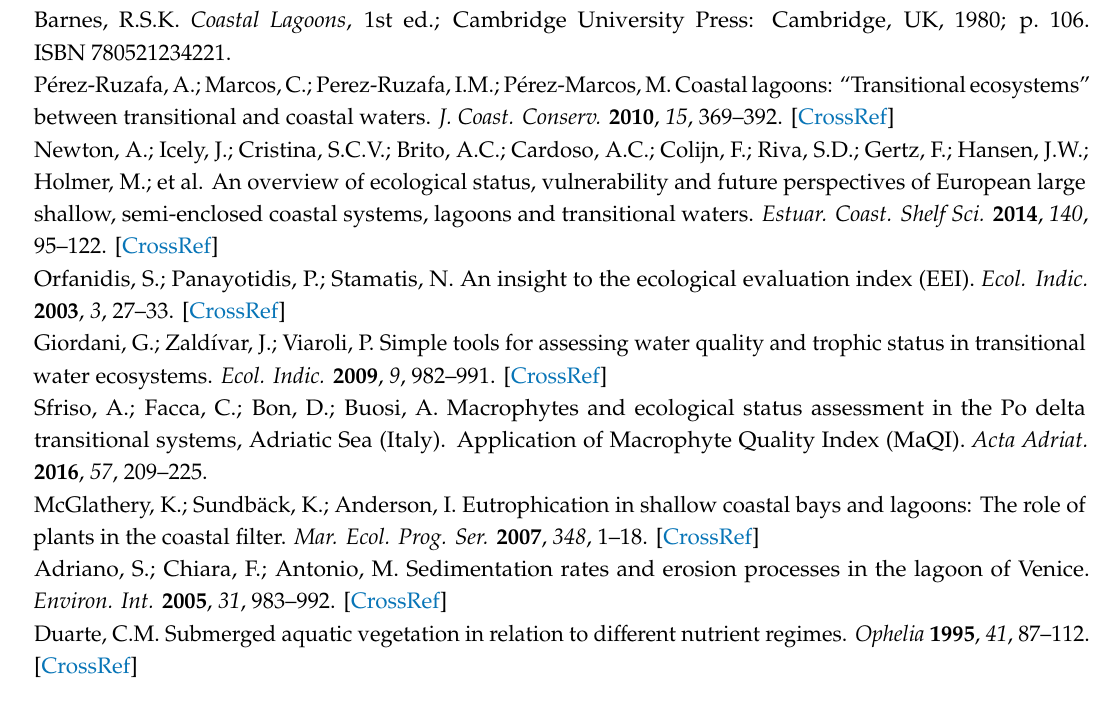
Table S1_1: Yearly averages of hydrochemical parameters in the three sampling stations for the whole study period. Lower and upper bounds of means (95%) are shown. Table S2_1: Landsat images used for the retrieval of macrophyte coverage. Figures_S2_1: Maps of satellite-derived macrophyte coverage retrieved by